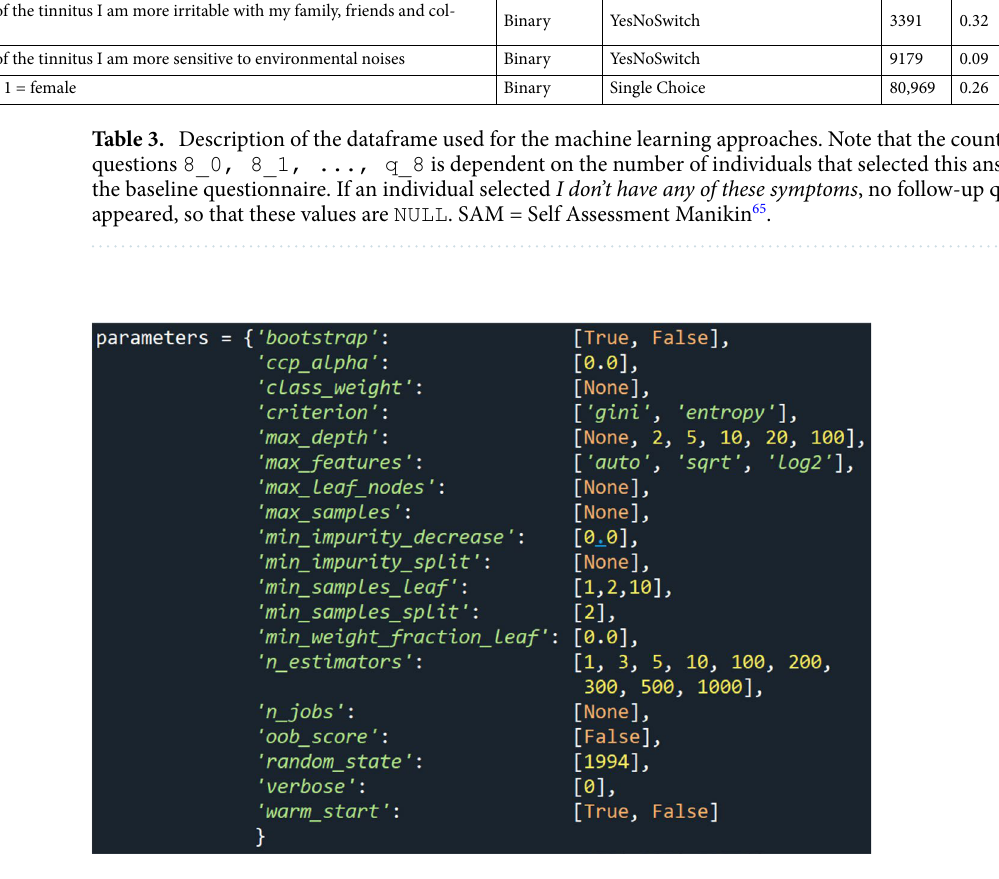
Figure 1. Set of hyper-parameters for a grid search in order to improve the forest’s accuracy. Note that not all hyper-parameters have be varied, such as n_jobs , oob_score or verbose . Only hyper-parameters were varied that have a higher impact on the accuracy score. However, static parameters are listed for the purpose of